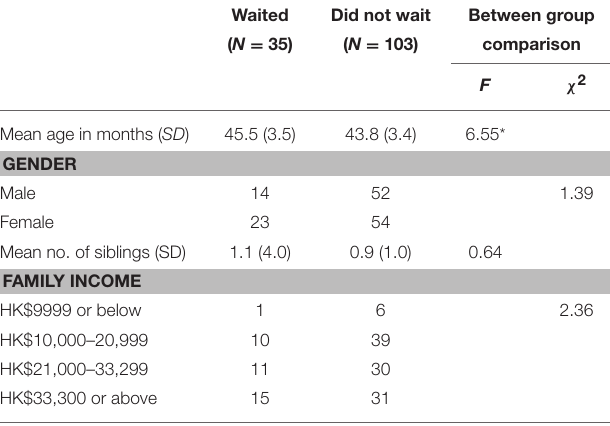
TABLE 1 | Participants’